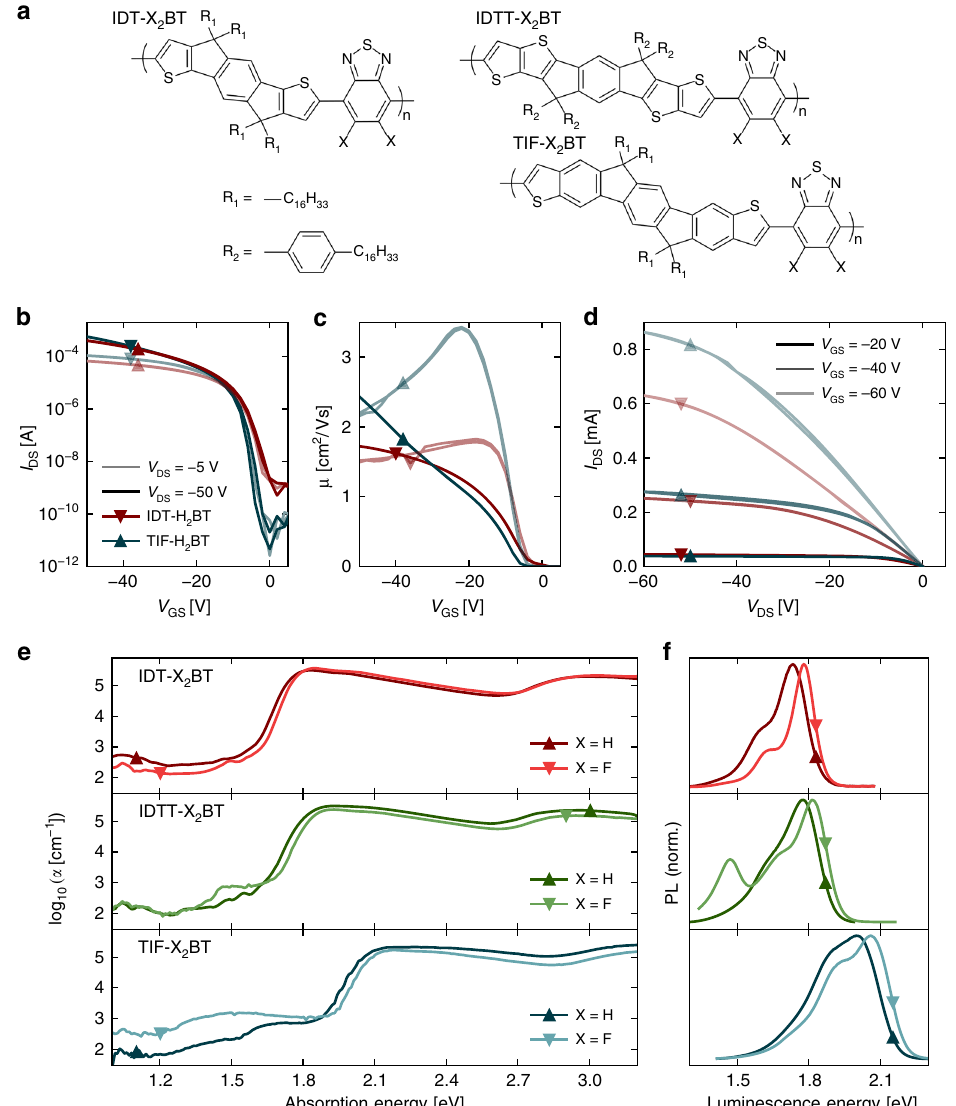
Fig. 2 Charge transport and optical properties of polymers in this study. a Structures of IDT-X 2 BT, IDTT-X 2 BT, and TIF-X 2 BT with X = H and F. Transfer characteristics ( b ), gate voltage dependence of mobilty ( c ) and output characteristics ( d ) for IDT-H 2 BT (red) and TIF-H 2 BT (blue). e PDS absorption and ( f ) normalised PL spectra of the